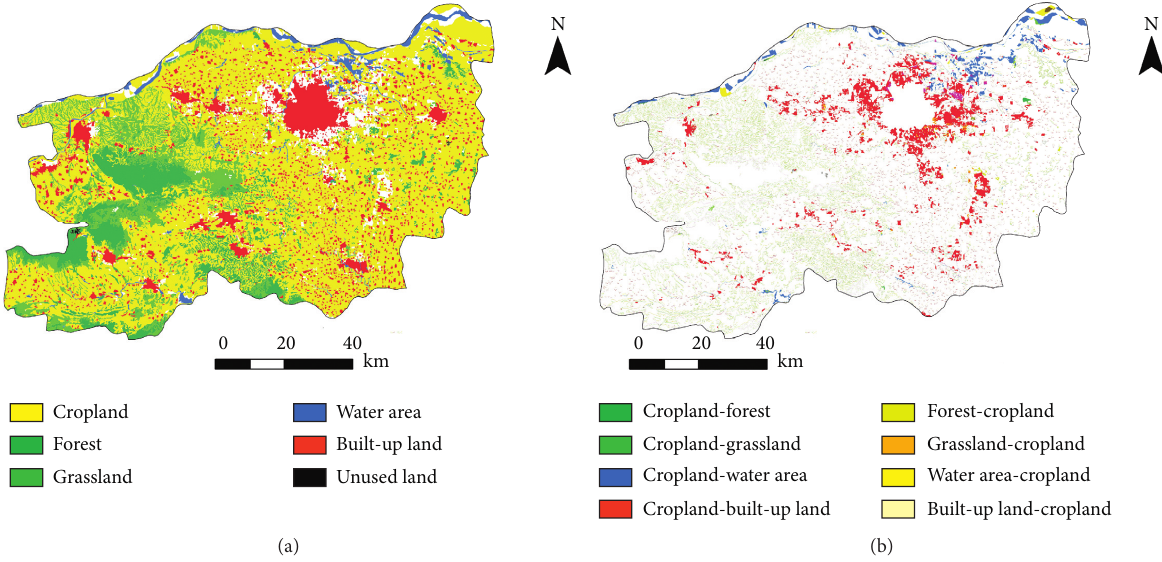
Figure 2: Spatial distribution of land without changes in land use type (a) and transferred land (b).